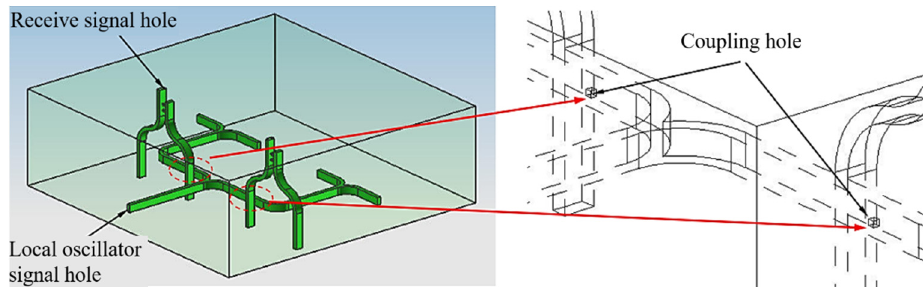
Figure 1. Schematic diagram of the 3D metal waveguide network.